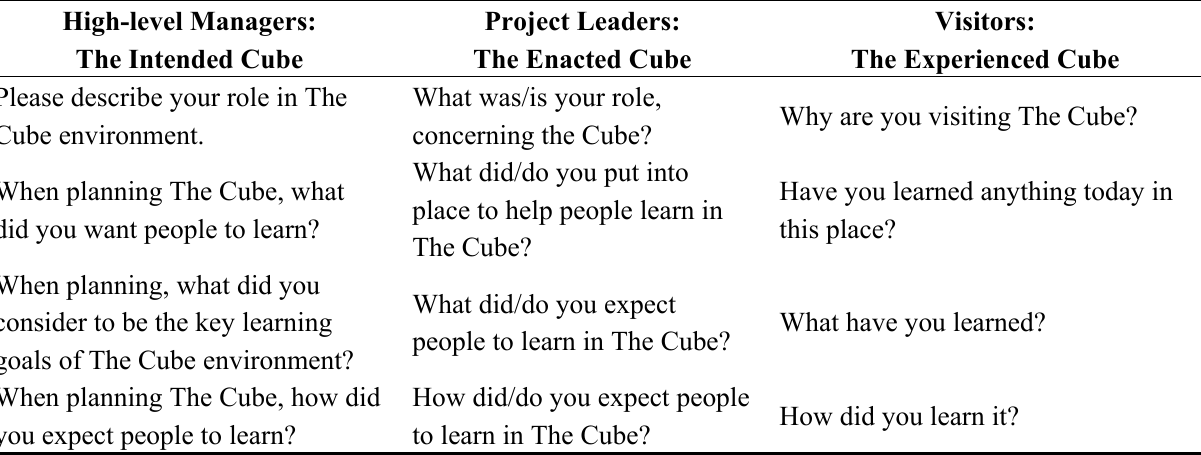
Table 1. Interview questions asked of the three stakeholders